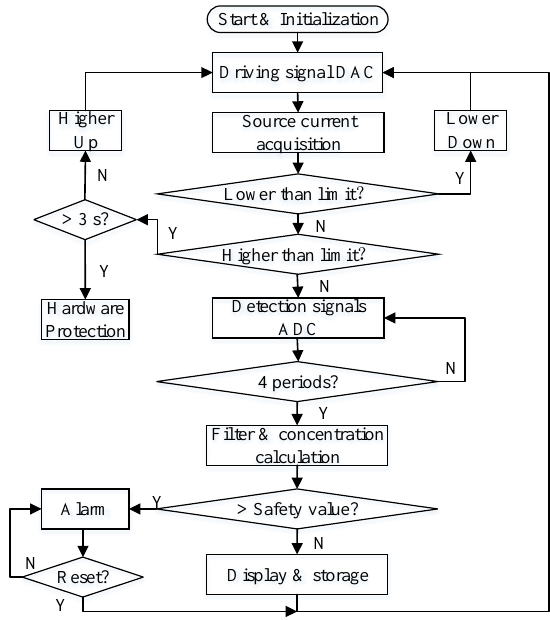
Figure 8. Flow chart of the sensor’s signal acquisition and processing.